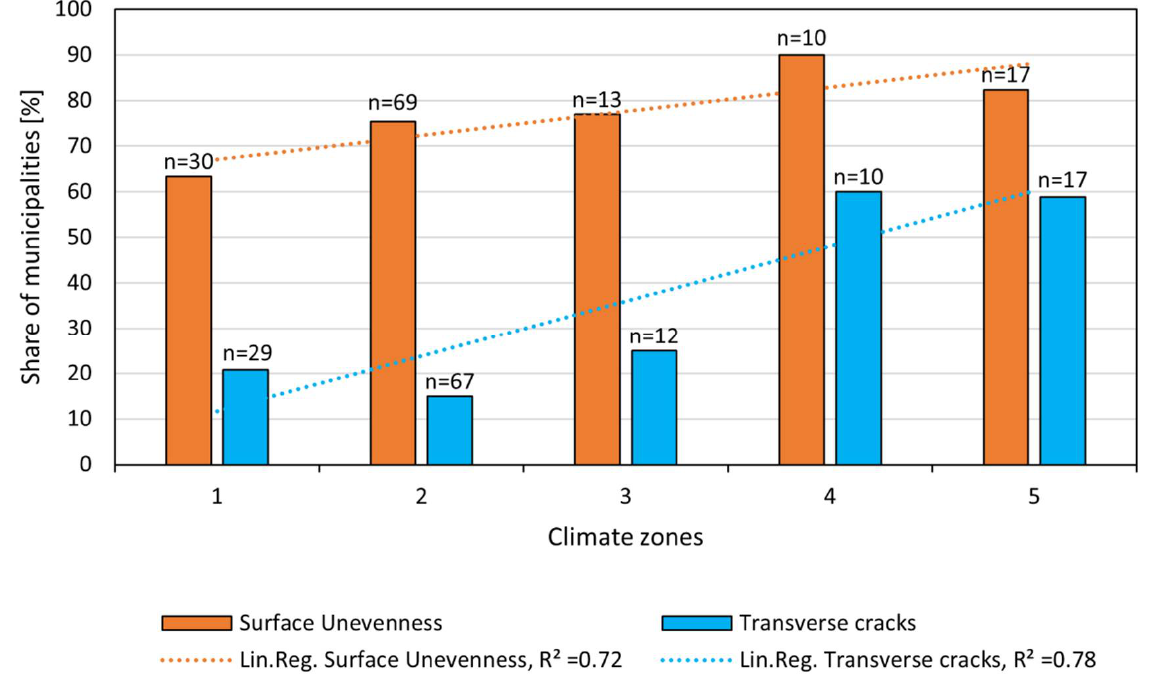
Figure 4. The correlation of the stated problematic frequency of surface unevenness and transverse cracks on municipal cycle paths with the climate zones in TRVK Väg .